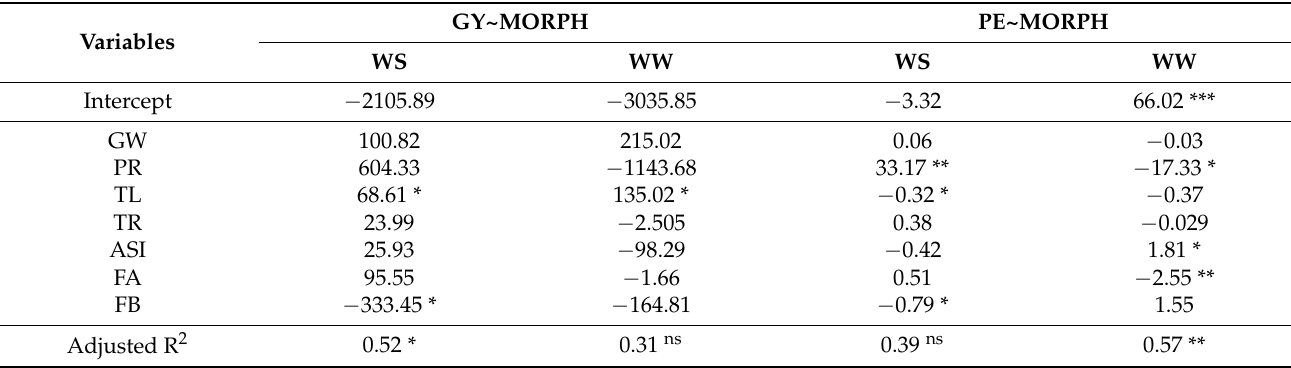
Table 2. Estimated beta values using multiple regression based on seven morphological (MORPH) traits (predictors) versus grain yield (GY) and popping expansion (PE) (dependent variables) of 20 popcorn inbred lines evaluated under two water conditions.